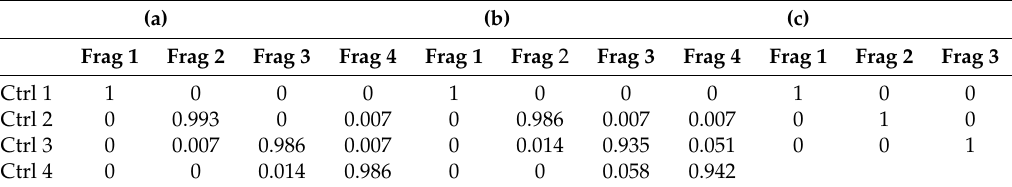
Table 3. Normalized confusion matrix for each heart region, ( a ) antero-septal, ( b ) lateral region, and ( c ) inferior region by using PCA. For each one, the ij value of the table represent the ratio of i -th component of control patient that is paired with the j -th component of synthetically fragmented patient according to the value of